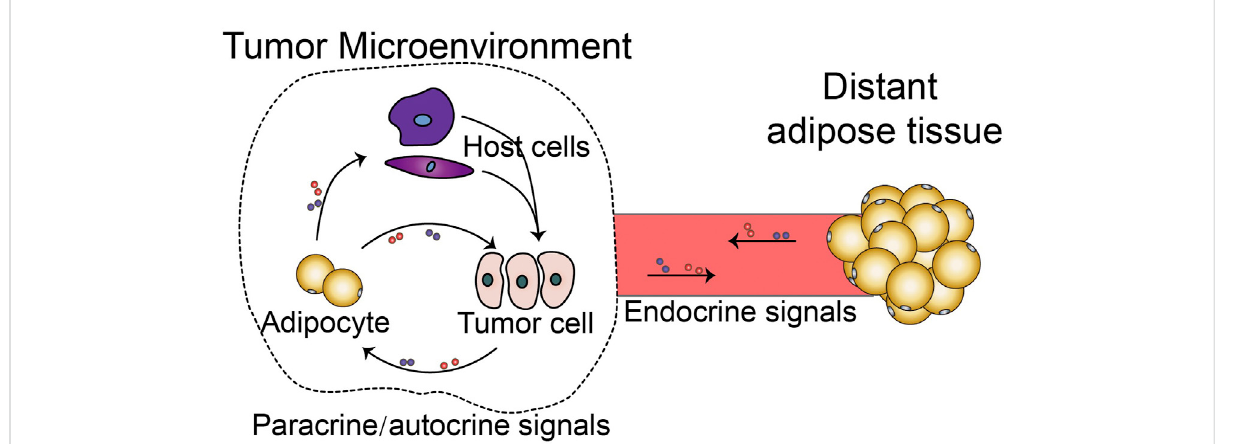
FIGURE 1 Adipocyte-tumor cell crosstalk in tumor microenvironment and tumor macroenvironment. (In the TME, CAA interacts with tumor cells via autocrine and paracrine signalings. Additionally, CAA indirectly promotes tumor cells via various host cell types in the TME. In contrast, distant adipose tissue systemically interacts with tumor cells or host cells via endocrine